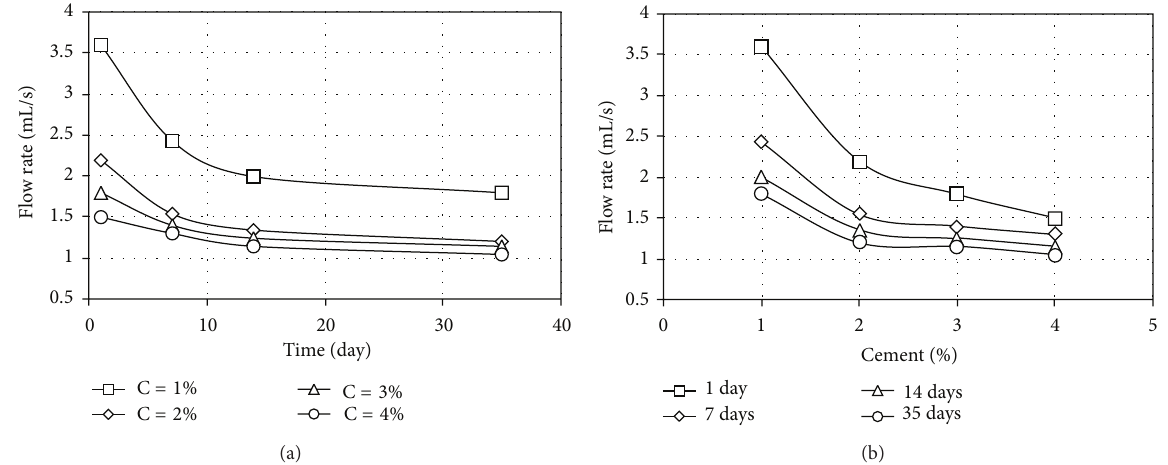
Figure 4: Flow rate for treated samples (a) of different cement contents and (b) of different curing times, for different cement contents.